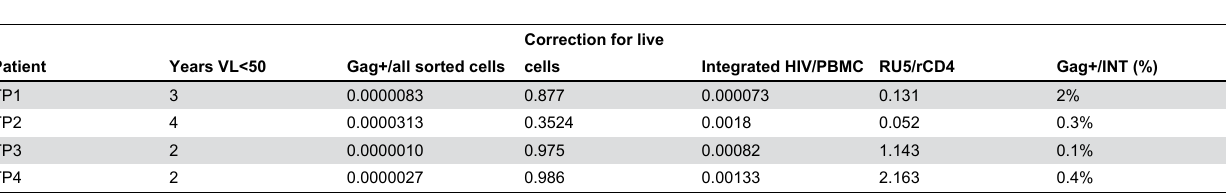
Table 1. HIV Gag is expressed in vivo in resting CD4+ T